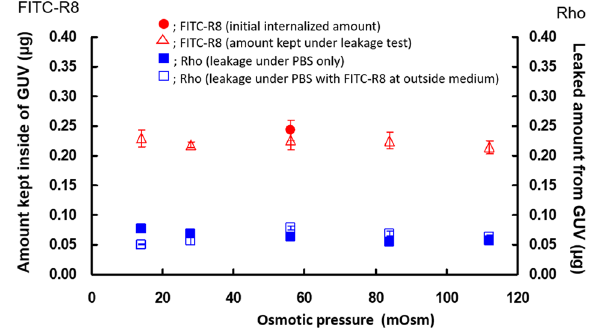
Figure 4. Effect of Osmotic pressure for the leakage of internalized FITC-R8 (CPP) and rhodamine (Rho) in the GUV (EPC, L/P = 1000, 10 min, 37 °C, n = 5).